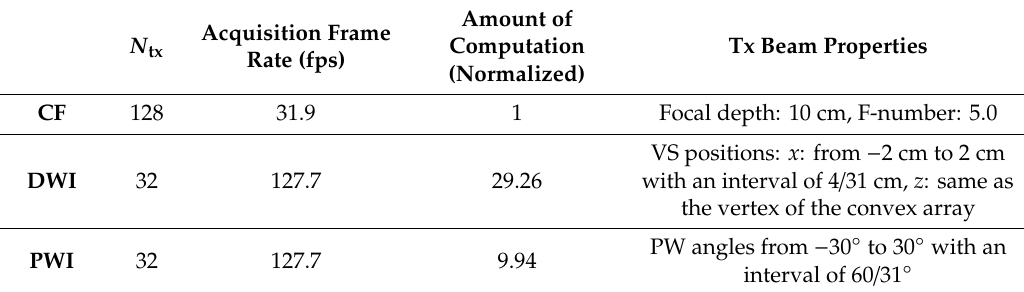
Table 1. Number of transmissions ( N tx ), acquisition frame rate considering the N tx , normalized amount of computations in the beamforming process, and Tx beam properties of conventional focusing (CF), diverging wave imaging (DWI), and plane wave imaging (PWI).